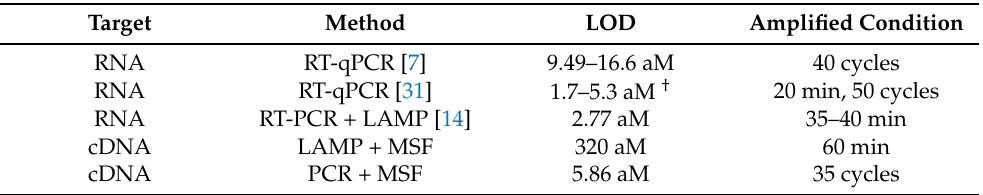
Table 2. SARS-CoV-2 detection for nucleic acids. MSF denotes the all-dielectric metasurface sensor is in this study. † Detection ratio of positive results discussed in the text was in a range from 3/6 to